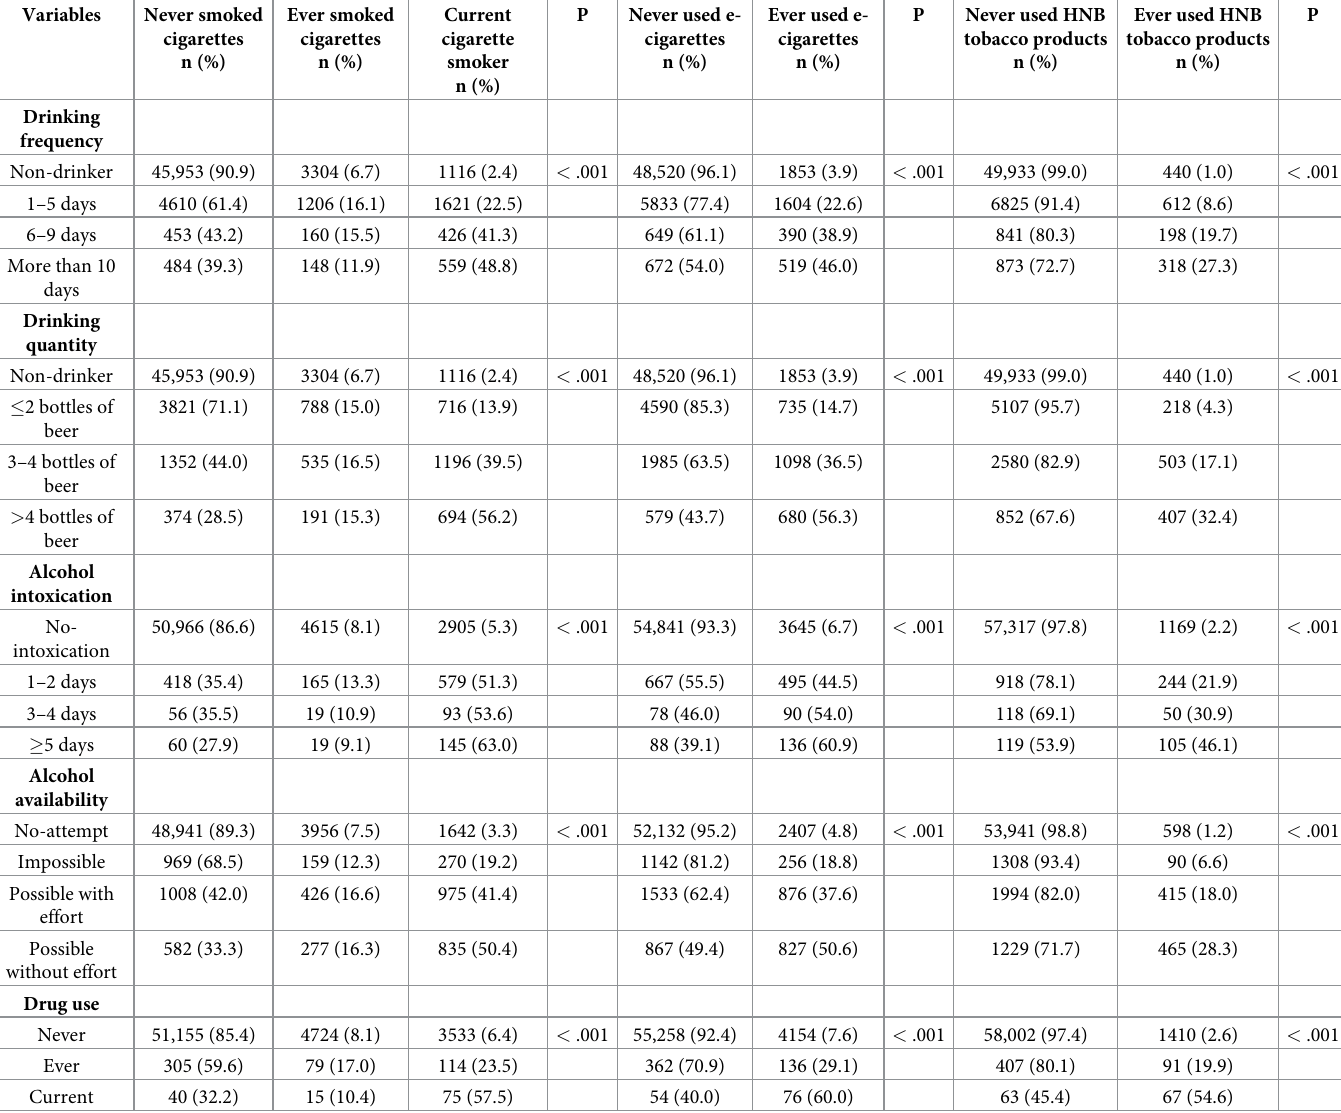
Table 2. Alcohol-related behaviors and drug use according to cigarette smoking status and ever-use of e-cigarettes and HNB tobacco products (N = 60,040) 1 . Variables Never smoked